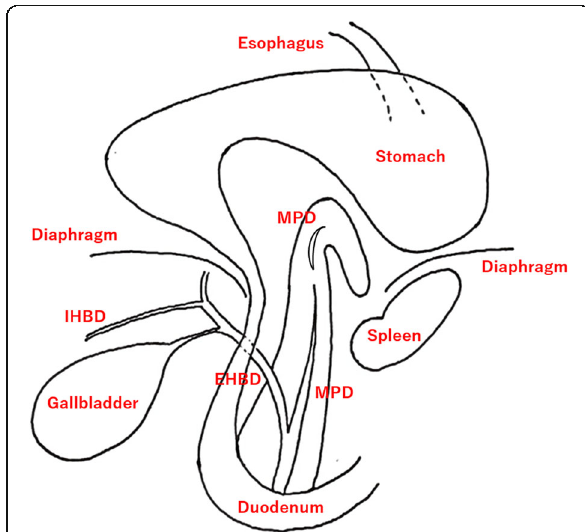
Fig. 5 Schematic illustration of pancreatic herniation. It was expected that acute pancreatitis occurs secondary to a massive hiatal hernia of the pancreatic body and tail. In addition, the bile and main pancreatic ducts were seen to be dilated. MPD: main pancreatic duct, IHDB: intrahepatic bile duct, EHBD: extrahepatic bile